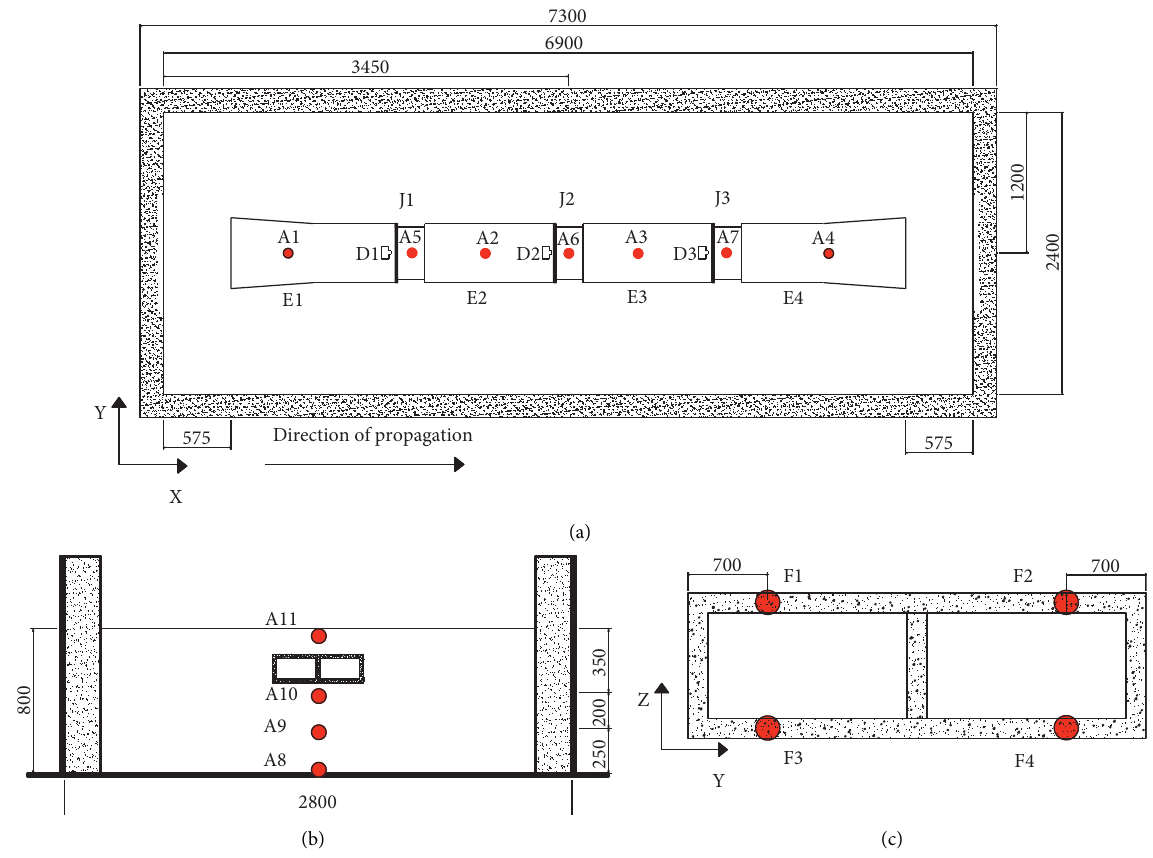
Figure 8: Measuring points arrangement: (a) layout of acceleration and laser sensor in soil and tunnel; (b) layout of acceleration sensor in soil; (c) layout of force sensor in joint.